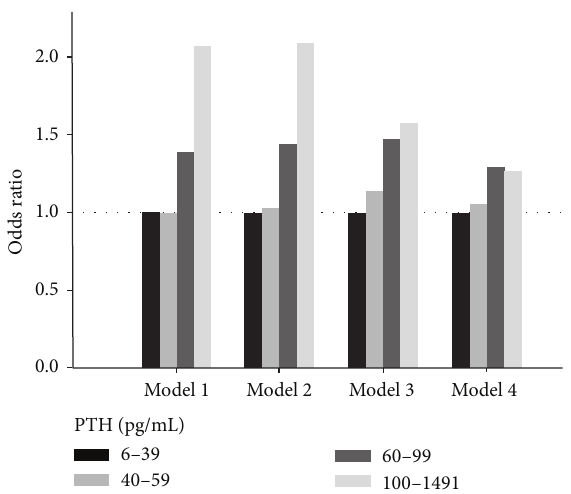
Figure 2: The odds ratios of increased modified Glasgow Prognostic Score according to parathyroid hormone (PTH) categories in NHANES 2003–2006. Model 1: adjusted for age and sex; Model 2: adjusted for age, sex, race/ethnicity, smoking status, and glycohemoglobin levels (continuous); Model 3: adjusted for variables in Model 2 plus albumin, triglycerides, and high-density lipoprotein levels (all continuous); Model 4: adjusted for variables in Model 3 plus corrected total calcium, 25-hydroxyvitamin D, and estimated glomerular filtration rate (all